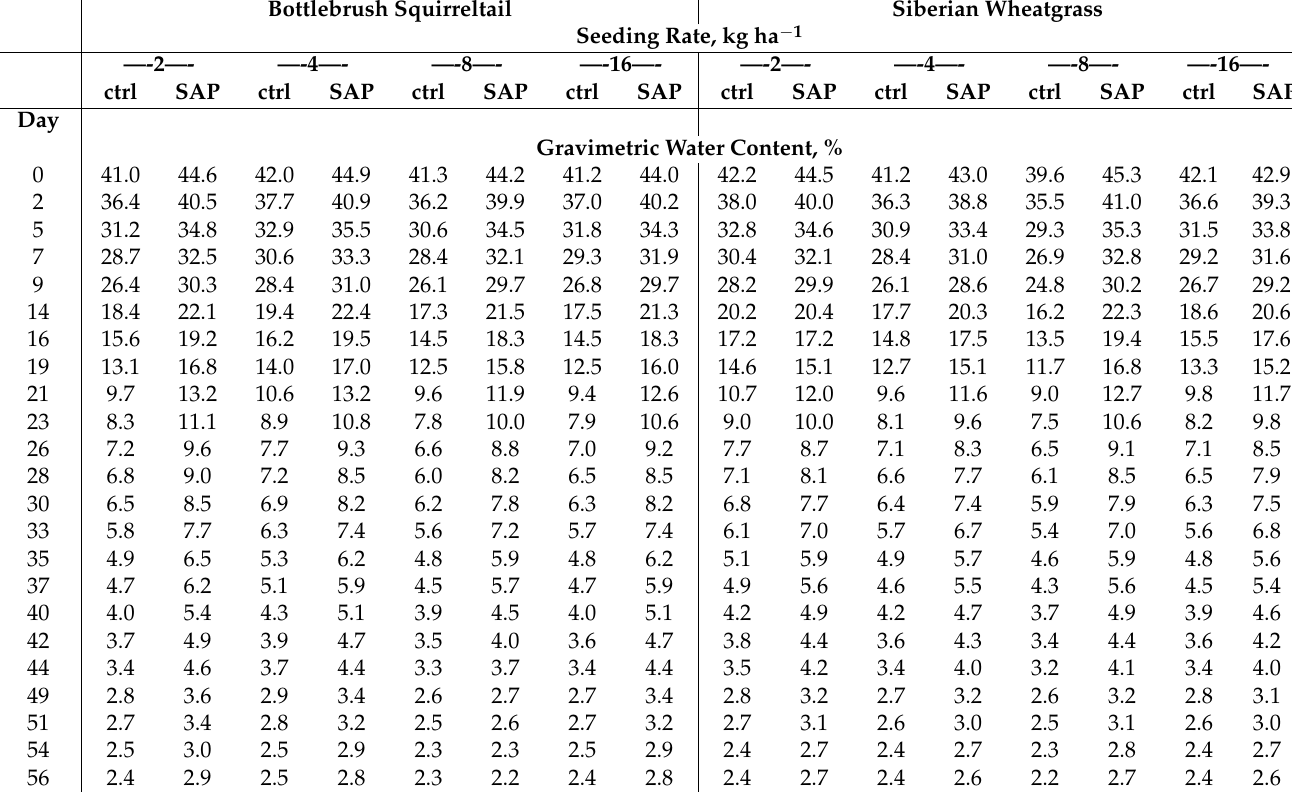
Table A1. Gravimetric water content (GWC) for bottlebrush squirreltail and Siberian wheatgrass grown in treatments with and without superabsorbent polymer (SAP) at seeding rates of 2, 4, 8, or 16 kg ha − 1 (1/4, 1/2, 1, or 2 times the NRCS recommended seeding rate). All treatments were watered only once to saturation and allowed to dry down.